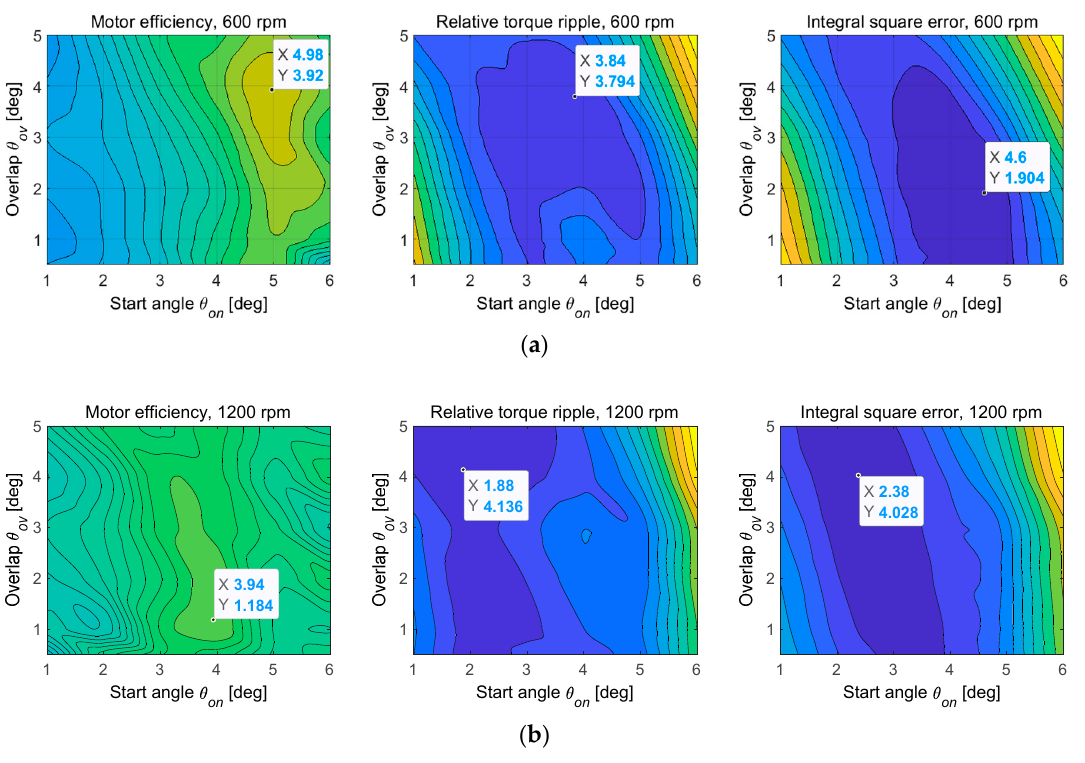
Figure 8. Values of the objective functions at load torque 1 Nm: ( a ) speed 600 rpm; ( b ) speed 1200 rpm.